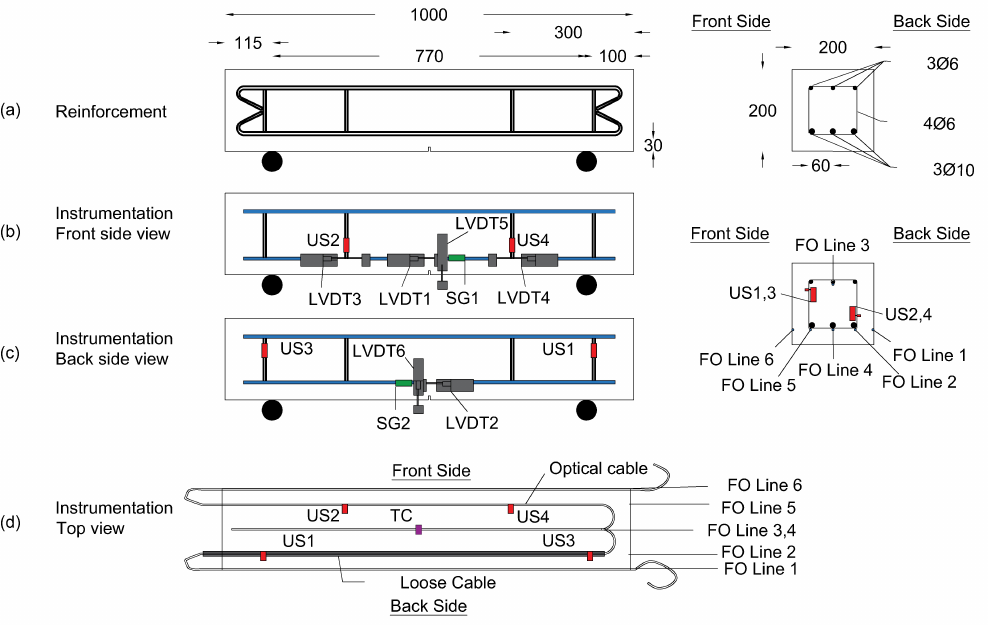
Figure 4. ( a ) dimensions of the beam and different rebars positions; ( b ) front view of sensors positions; ( c ) back view of sensors positions; ( d ) top view of sensors positions.